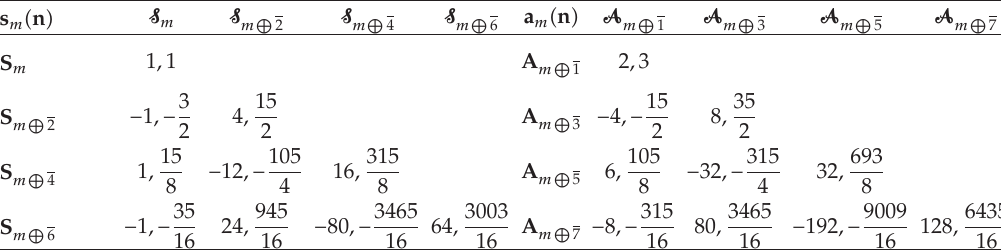
Table 1: Coe ffi cients of lower order fabric tensors of the second kind using asymmetric characterization for tensor-valued ODFs (cid:3) 2D and 3D (cid:4)